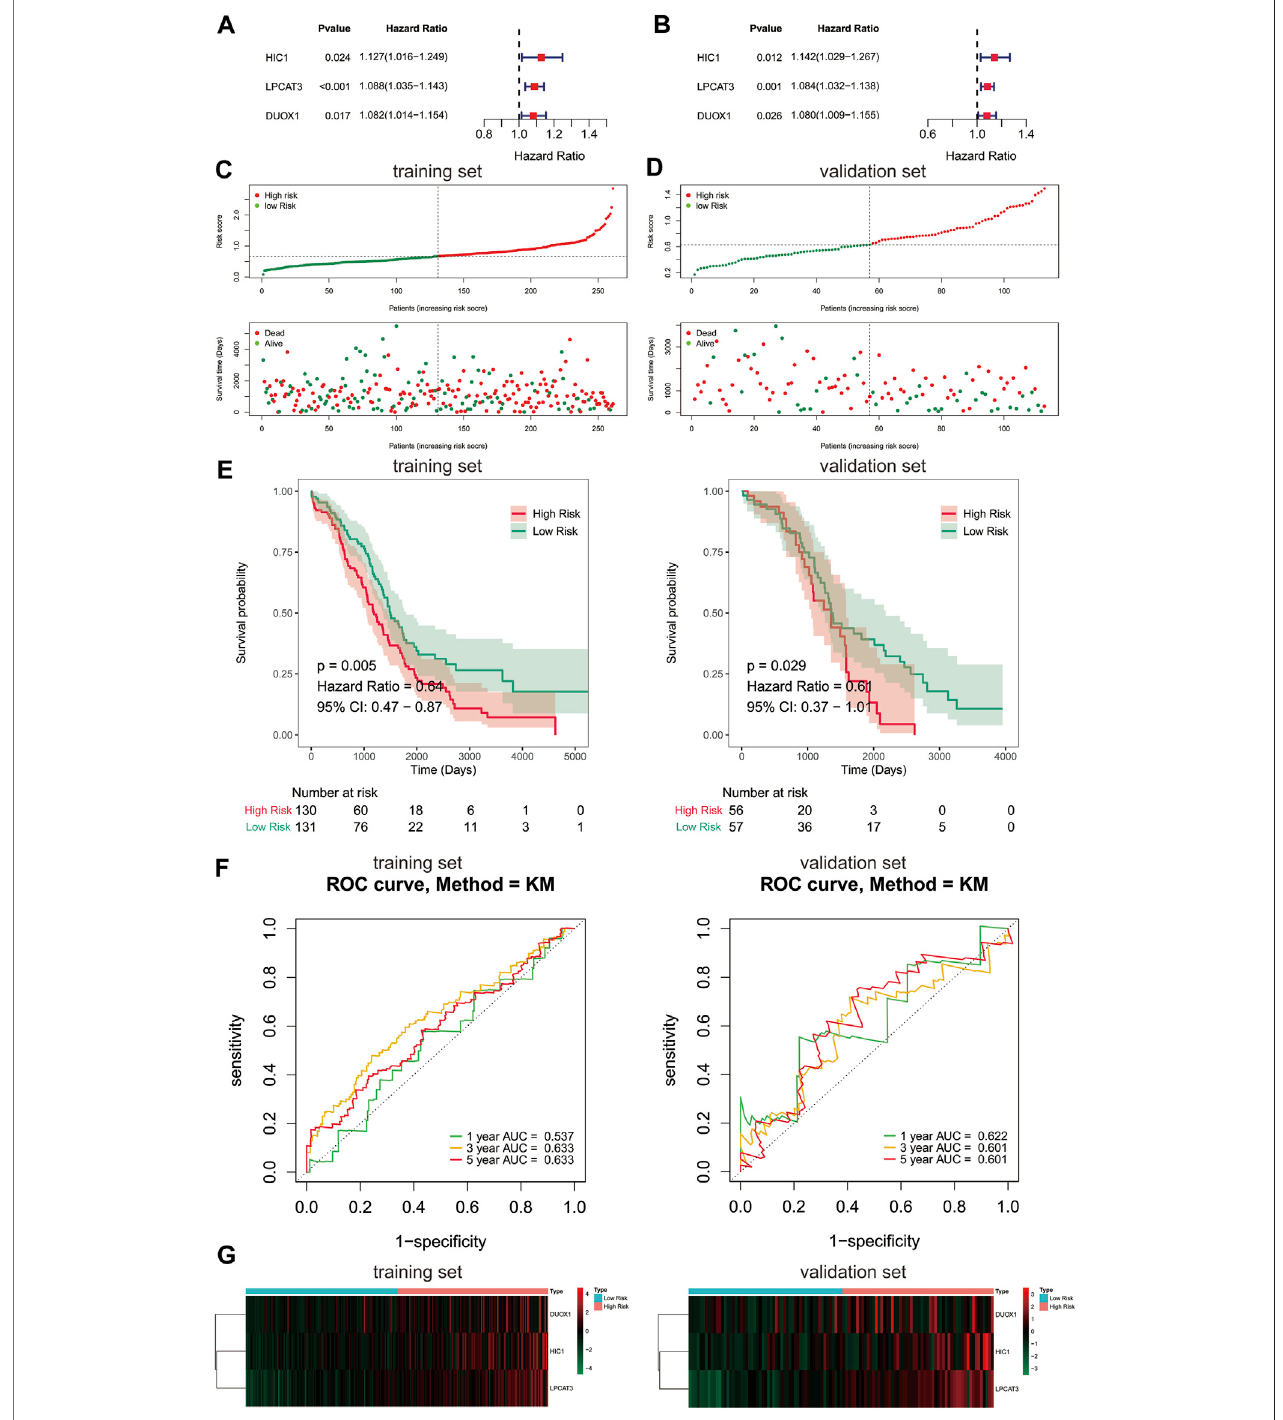
FIGURE 2 | Construction of prognostic gene signature with FRGs in TCGA cohort. (A, B) Forest plots showing the results of the univariate and multivariate Cox regressionanalysisbetweengeneexpression andOSinthetraining set.Distributionofriskscoreforeach patient andsurvivalstatus ofOCpatients inthetrainingset (C) and validation set (D) . (E) Kaplan-Meier curves for the OS of patients in the high-risk group and low-risk group in the training set (left) and validation set (right) . (F) The ROC analysis of training set (left) and validation set (right) for survival prediction by the three-gene signature. (G) Heatmap of the gene-expression pro fi les of the FRGs signature in the training set (left) and validation set (right) . OS, overall survival; OC, ovarian cancer.